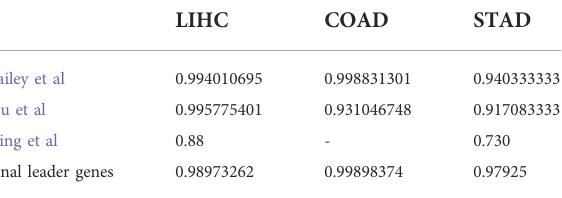
TABLE 8 Classi fi cation performance of the result genes used as features of SVM of the algorithm in this article and the latest existing